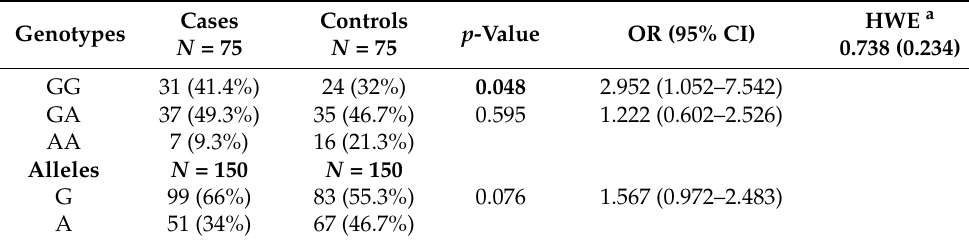
Table 1. Genotypes and allele frequencies of the C1q rs292001 single nucleotide polymorphism analyzed in 75 patients with type 2 diabetes and asymptomatic bacteriuria (cases) and in 75 patients with type 2 diabetes without asymptomatic bacteriuria